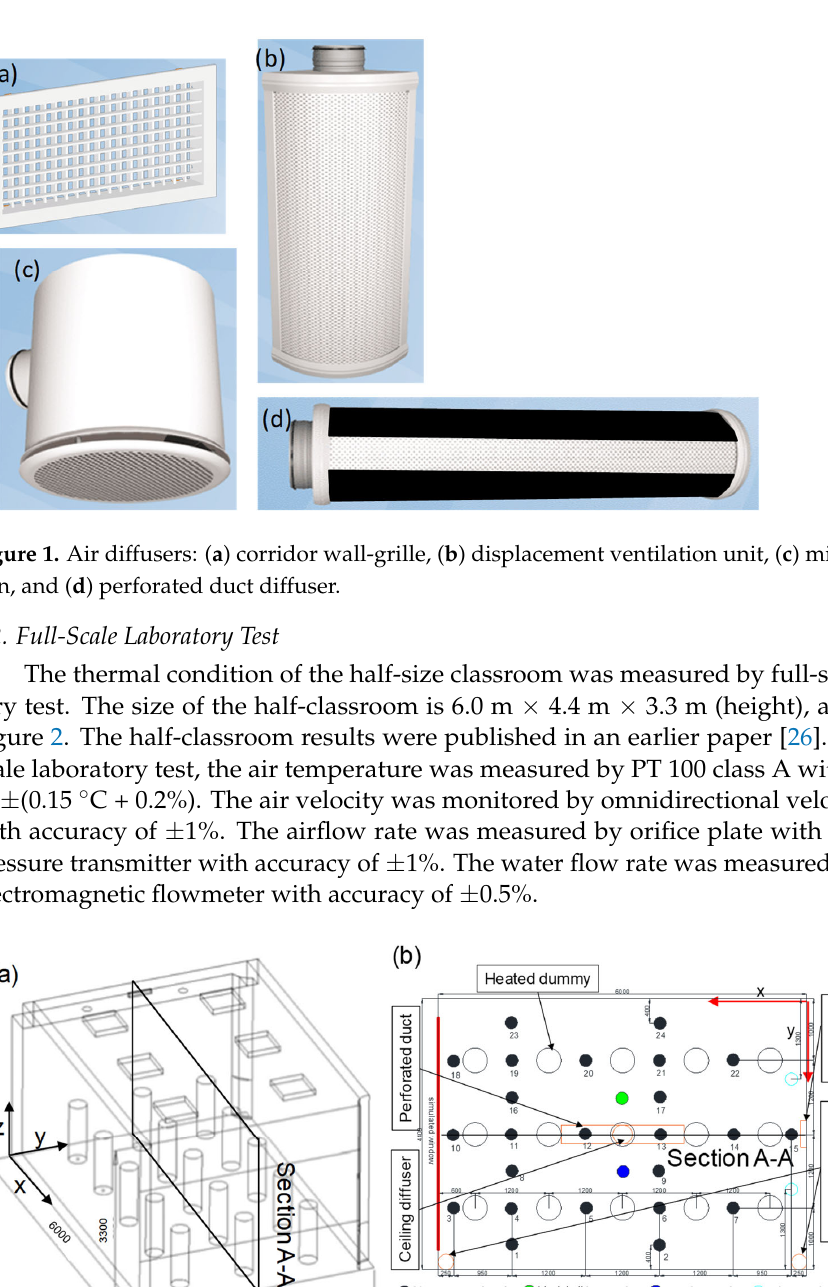
Table 1. Details of CFD ‐ simulation. CFD Software